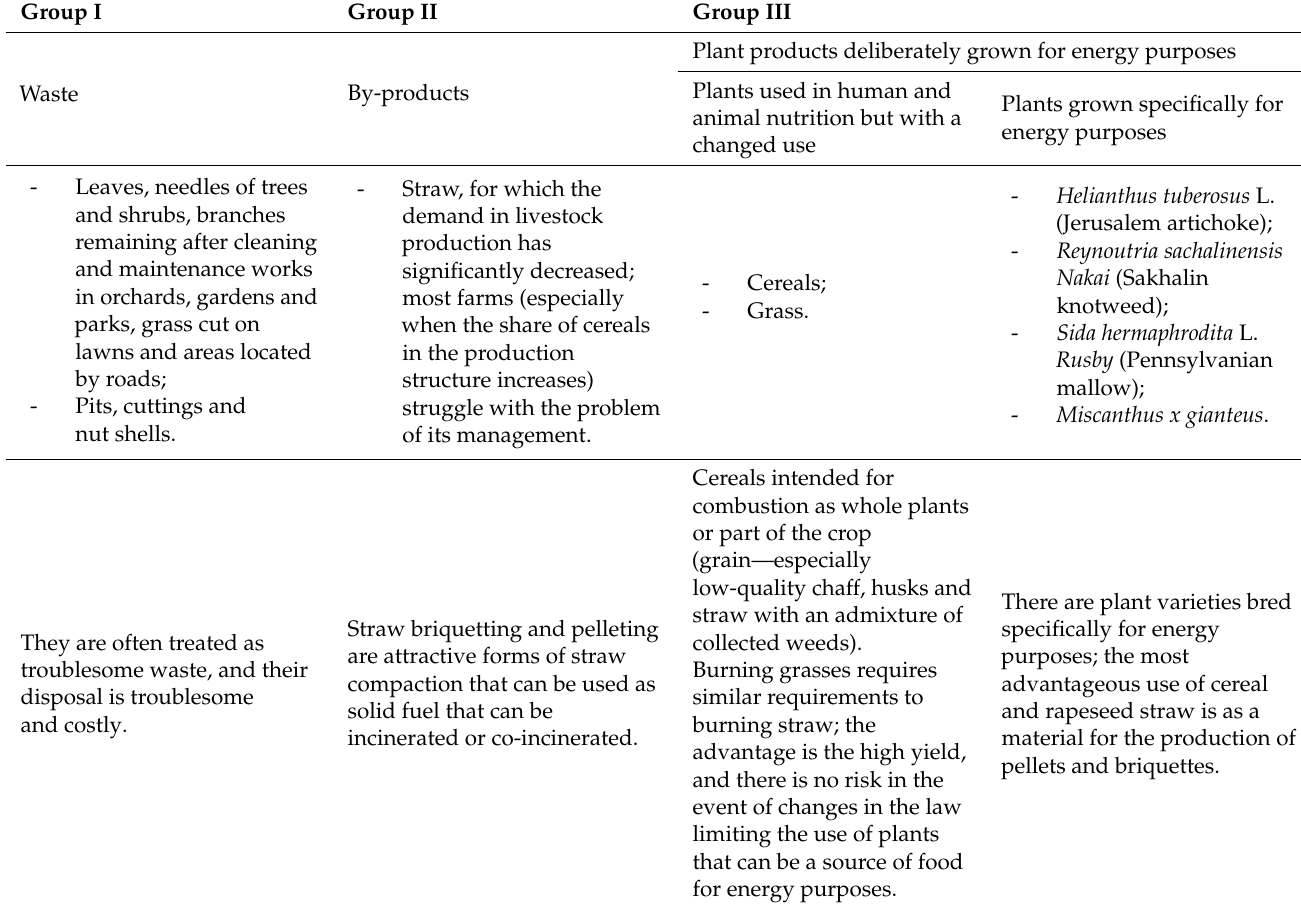
Table 1. Materials of biological origin for combustion (own